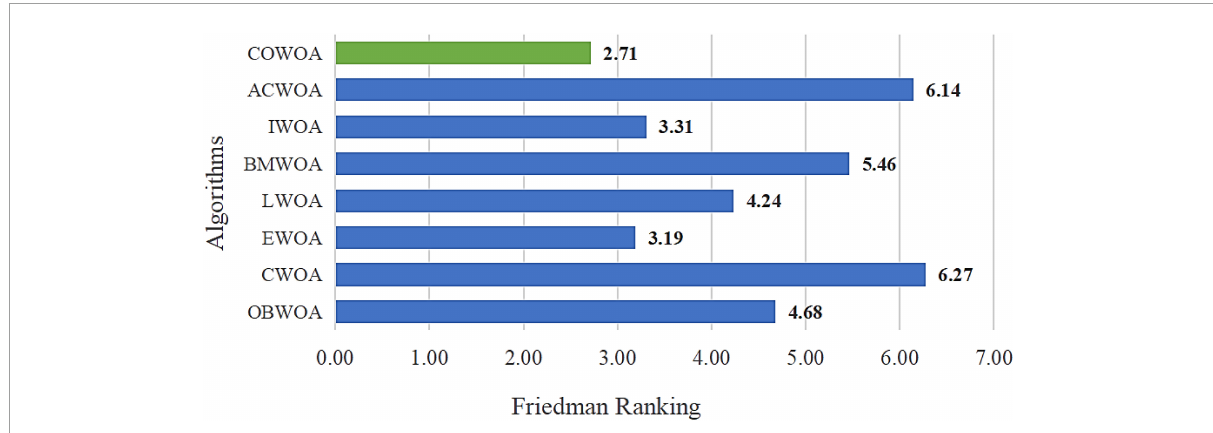
FIGURE7 Result of Friedman ranking between the COWOA and the well-known WOA variant